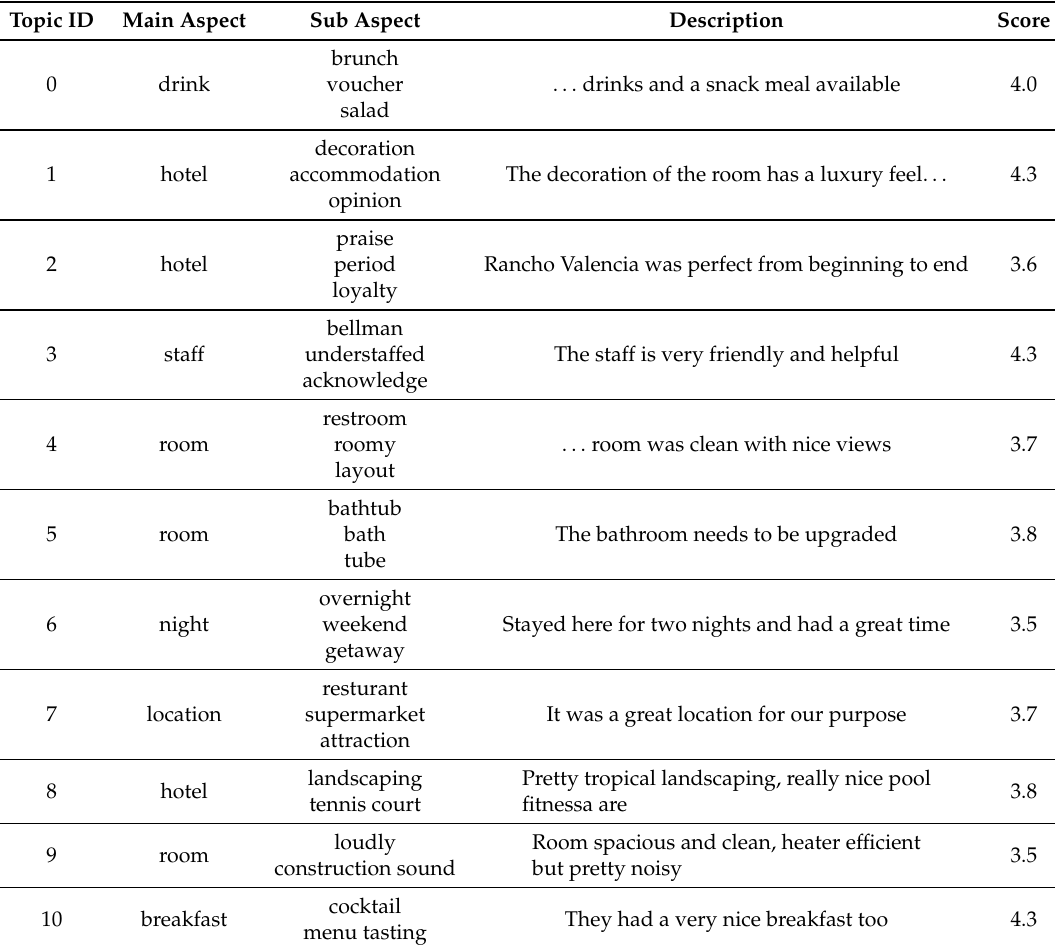
Table 6. Main and sub aspects per topic.